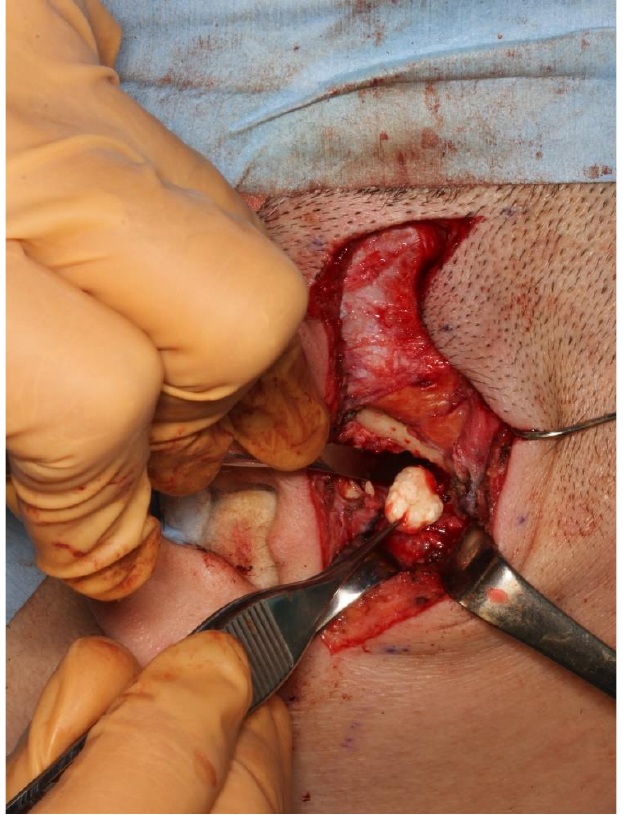
Figure 4. Intraoperative photograph. The whitish calcified tumorous mass was enucleated from the right infratemporal fossa.